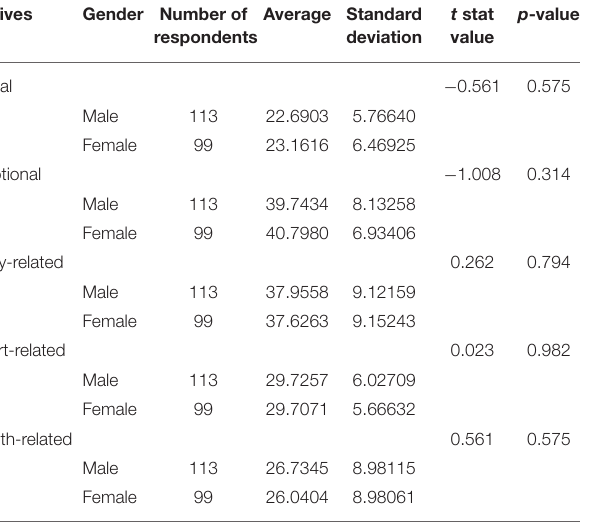
TABLE 16 | Men vs. women in traditional water events. Motives